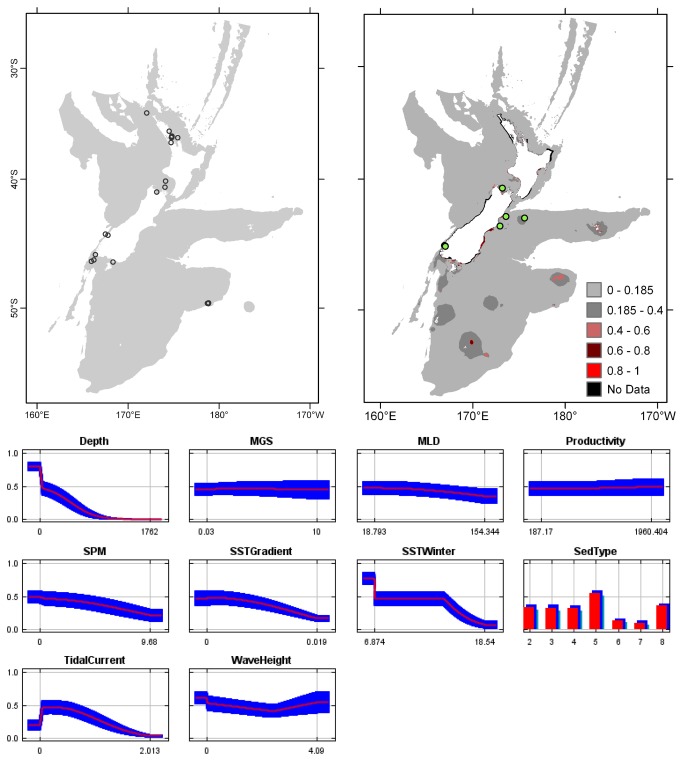

Smittoideamaunganuiensis

 known distribution (left), predicted suitable habitat (right), and fitted responses curves (marginal).For the predicted distribution, logistic probabilities less than the 10th percentile presence value indicated cells were unsuitable habitat. Probabilities of 0.4–0.6 indicated habitat suitability typical of the presence records, values of 0.6–0.8 and 0.8–1 indicated favourable and highly suitable habitat, respectively. Black cells had missing data in one or more environmental layer. Independent records are layed over the predictions. Marginal response curves show how the prediction changes for different values of each variable when all other variables were at their average sample value. Individual response curves are shown in Figure S3. For the categorical variable Sediment type: 1 = deep ocean clays; 2 = calcareous gravel; 3 = volcanic; 4 = calcareous mud; 5 = gravel; 6 = mud; 7 = sand; 8 = calcareous sand.